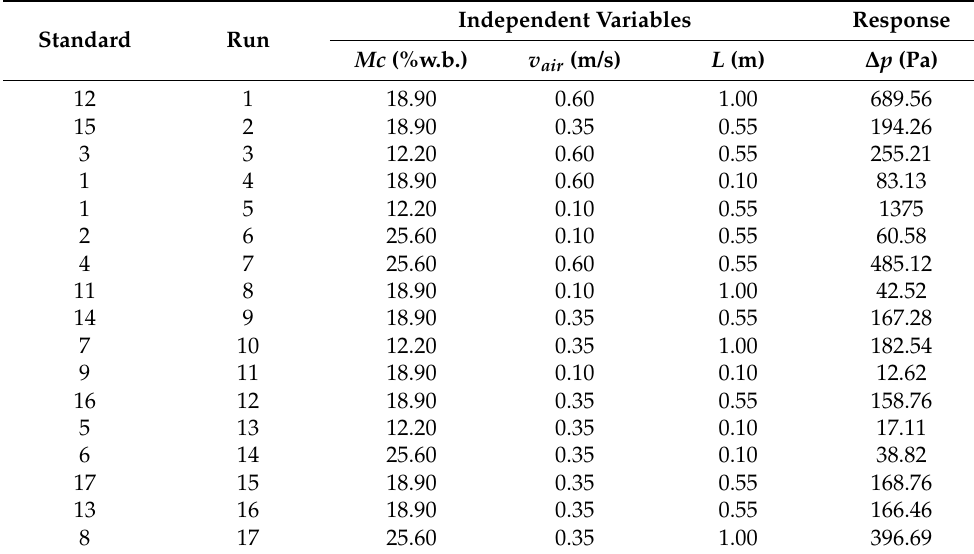
Table 3. Experimental design for the tests.